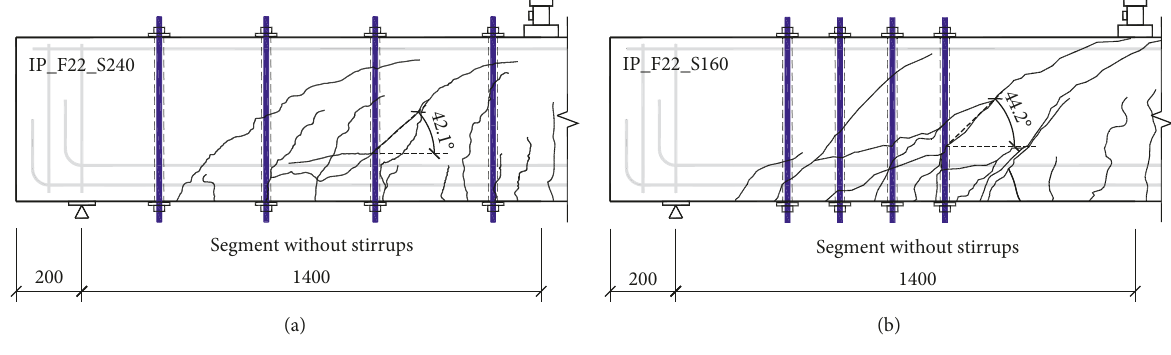
Figure 6: Depiction of cracking pattern at shear failure for IP_F22_S240 and IP_F22_S160 (units: